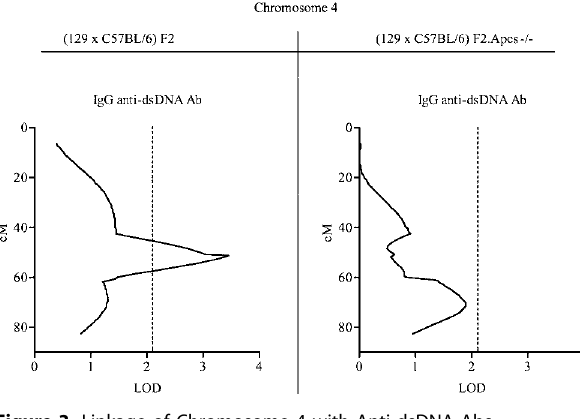
Figure 3. Linkage of Chromosome 4 with Anti-dsDNA Abs The estimated peak in (129 3 C57BL/6)F2 mice was at position 51.3 cM, whilst in the (129 3 C57BL/6)F2 .Apcs (cid:1) / (cid:1) animals it was was at position 71 cM, indicating that most likely these were two independent loci. Centimorgan positions were deduced by interval mapping, anchoring marker locations to data from http://www. informatics.jax.org. Dotted lines the indicate threshold over which linkage was considered suggestive, as defined in Materials and Methods